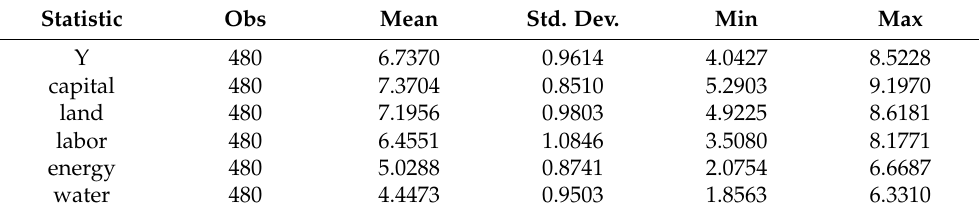
Table 1. Summary statistics for logarithmic output, labor, capital and